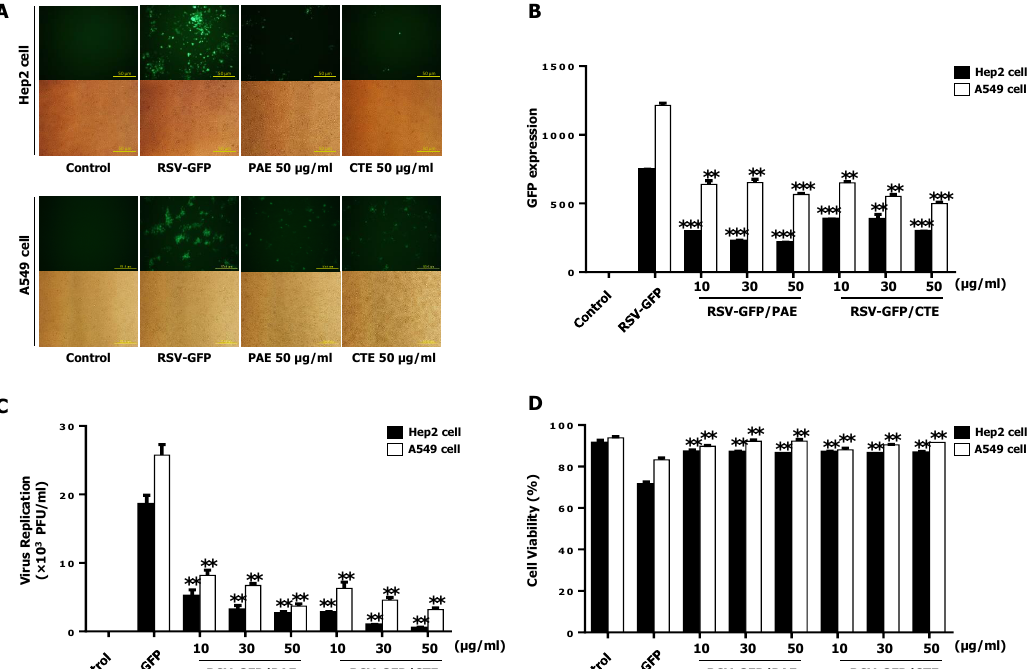
Figure 1. Antiviral activity of Plantago asiatica extract (PAE) and Clerodendrum trichotomum extract (CTE) in HEp2 cells and A549 cells. HEp2 cells and A549 cells were seeded into 12 well cell culture plates with the cell number of 2.5 × 10 5 cells / well. Twelve hours later, the medium was changed to 1% fetal bovine serum (FBS) containing Dulbecco’s Modified Eagle’s Medium (DMEM) and cells were infected with Green Fluorescent Protein fused Respiratory syncytial virus (RSV-GFP) 0.1multiplicity of infection (MOI) or kept uninfected. Two hours later, the medium was replaced with 10% FBS containing DMEM and cells were treated with 10, 30, 50 ( µ g / mL) PAE or CTE. Cells without any treatment regard as virus only. ( A ) After 48 h, images were obtained (200 × magnification). ( B ) GFP absorbance levels were measured by Gloma multi-detection luminometer (Promega). ( C ) Virus titration was done from the cell supernatant and cells by standard plaque assay and expressed as plaque forming unit (PFU). ( D ) Cell viability was determined by trypan blue exclusion assay at 48hour post infection (hpi). GFP absorbance, cell viability and virus titer expressed as mean ± standard deviations (SD). Error bars indicate the range of values obtained from counting duplicate in three independent experiments (** p < 0.01 and *** p < 0.001 regarded as significant di ff